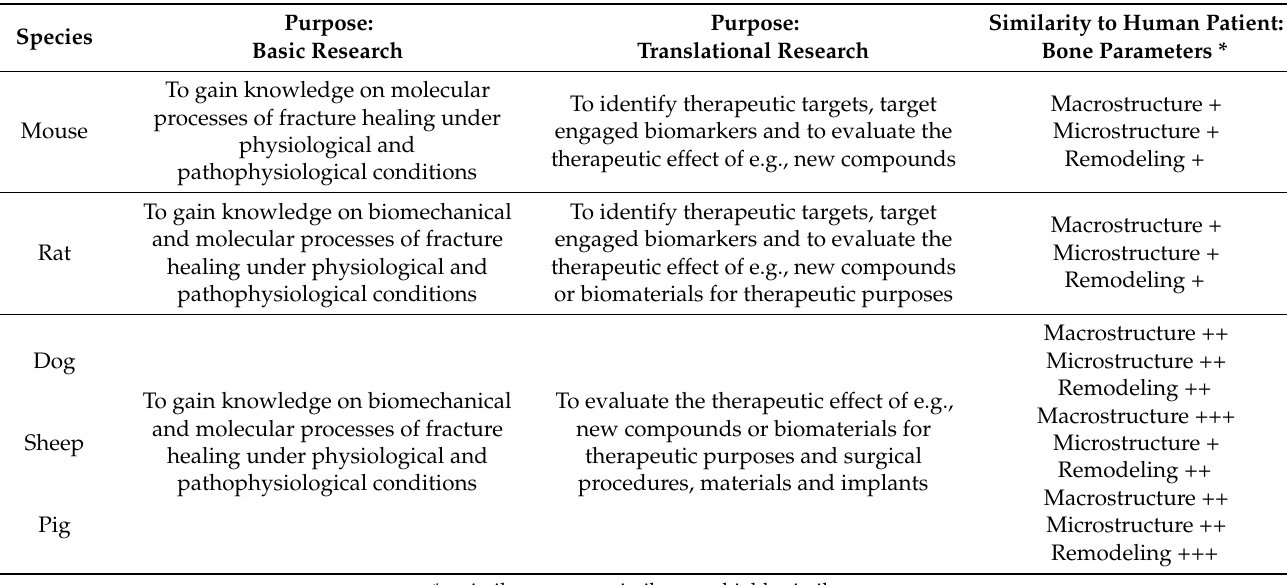
Table 1. Overview of the usability of various animal models